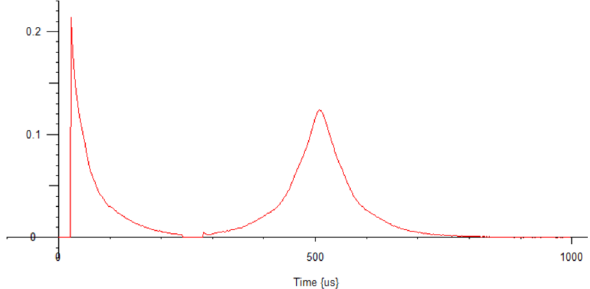
Fig. 7 An NMR FID and Echo from a small 5mm OD water sample, measured in the Mandhalas